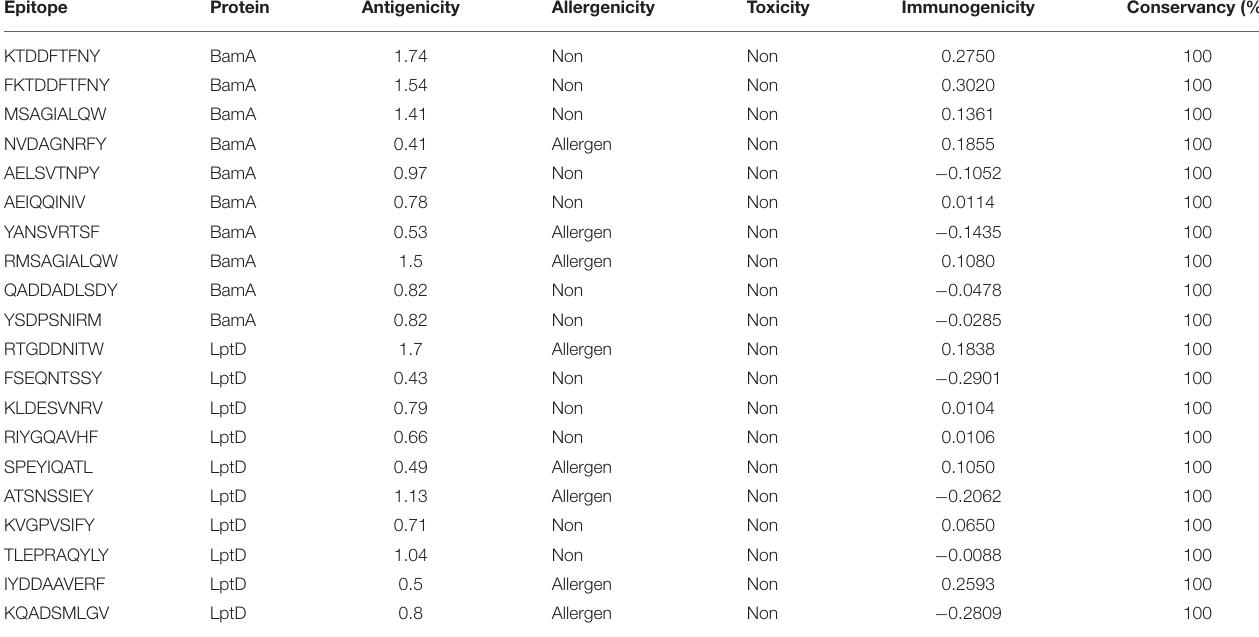
TABLE 1 | Top-ranked T-cell epitopes (MHC-I peptides) of BamA and LptD proteins. Epitope